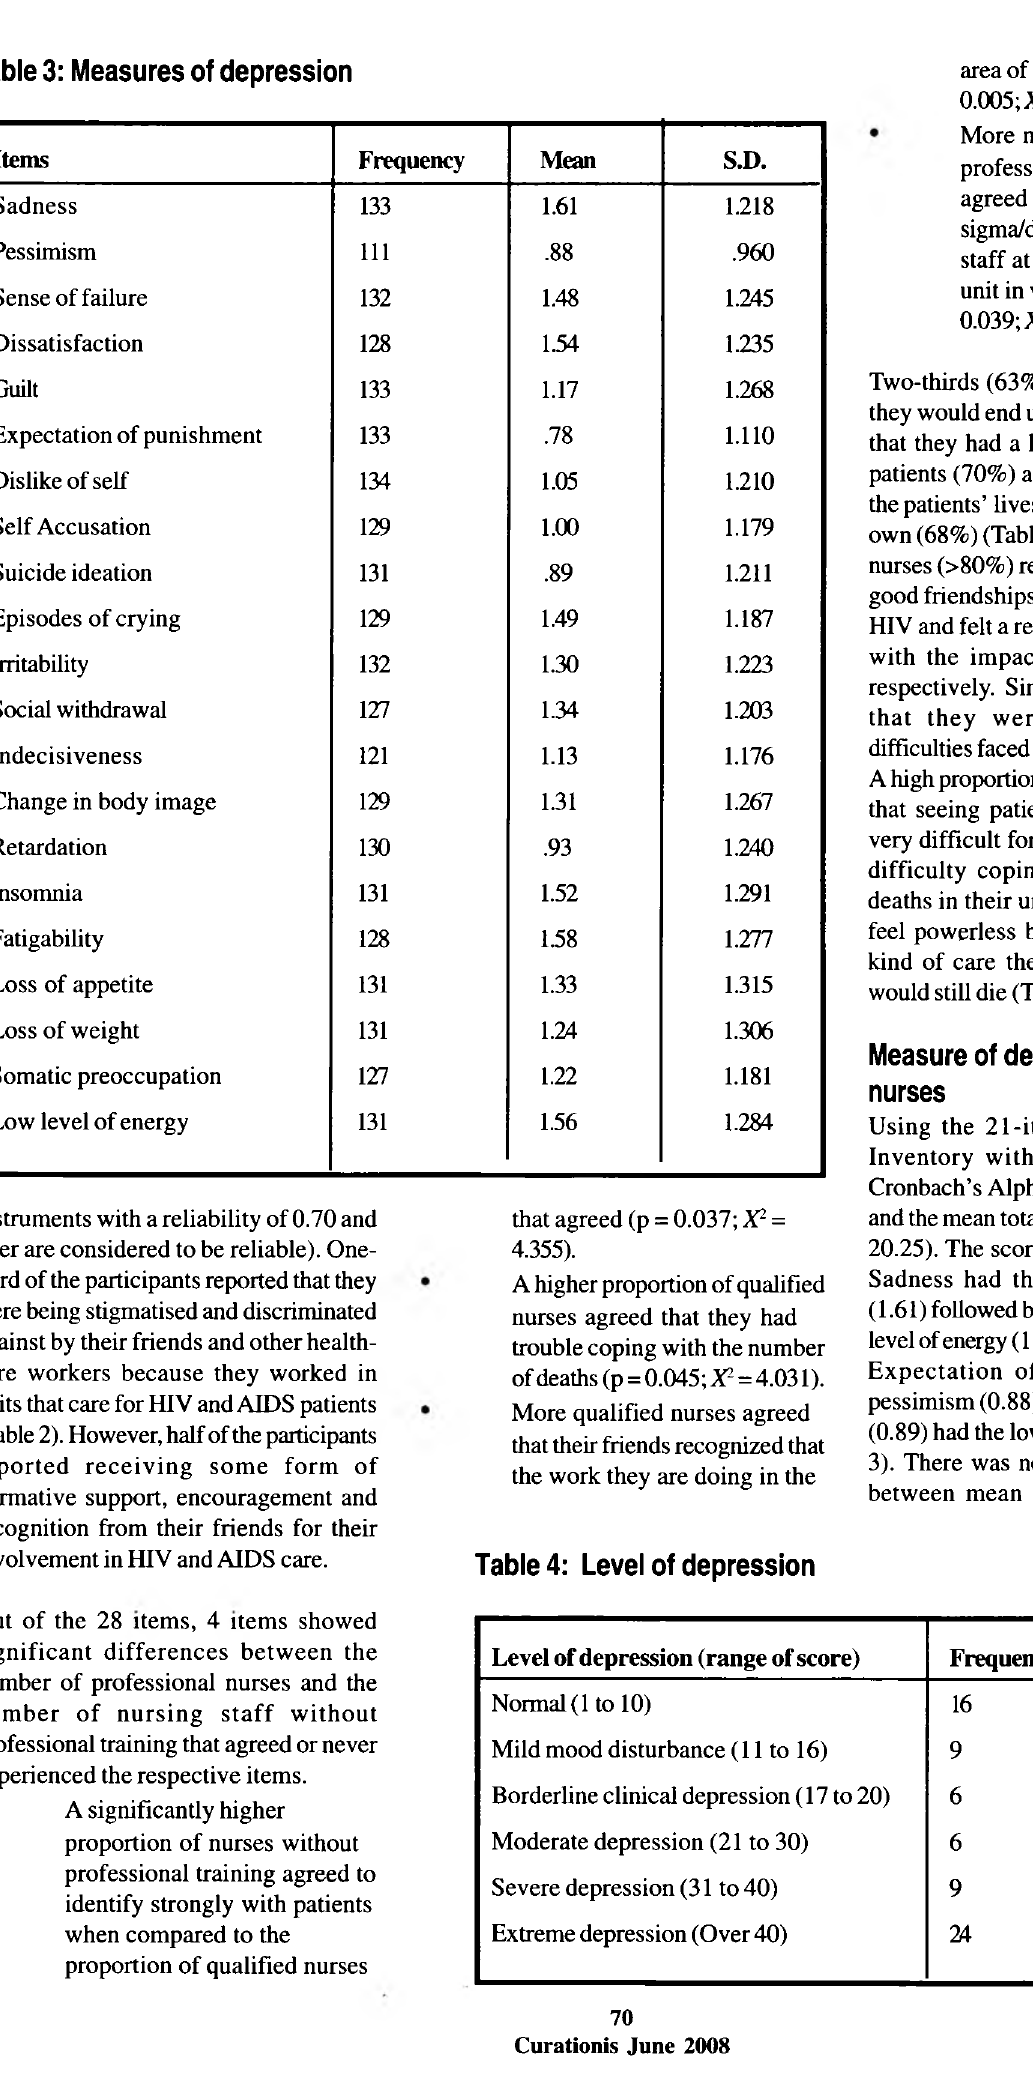
Table 3: Measures of depression area of HIV is valuable (p =